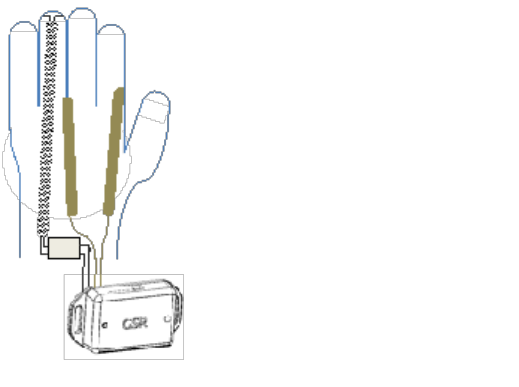
Figure 2. GSR device with a drawing of the connection with the sensorized